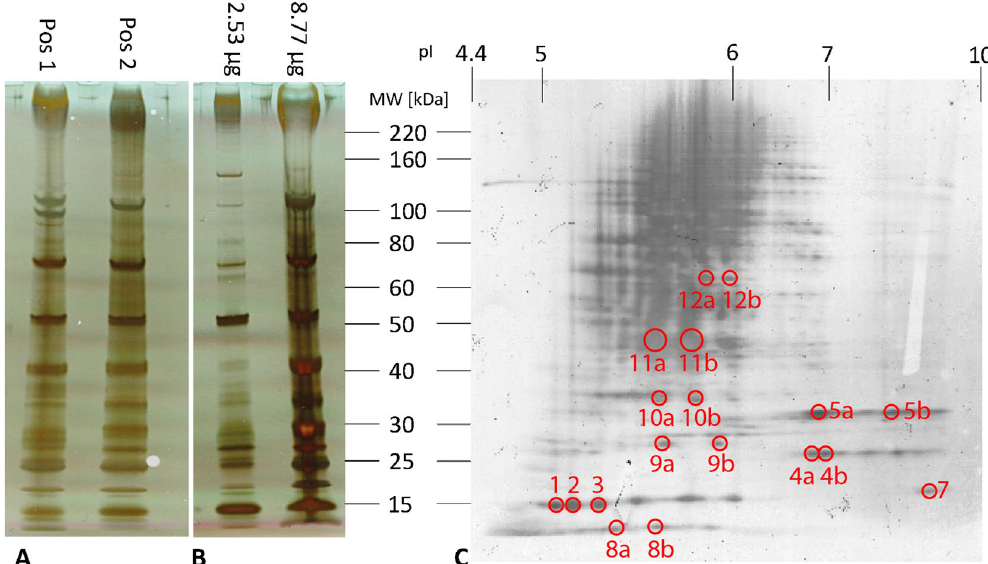
Figure 5. 1D- and 2D-PAGE. 1D-PAGE of the salamander secretion ( A ) extracted with LDS buffer from two different positions of an Aclar ® foil (approx. 0.75 cm 2 each) and ( B ) different concentrations of bioadhesive scratched from the Aclar ® foil over an area of 2 cm 2 solubilized in LDS buffer. ( C ) 2D-PAGE of 44 µ g protein extracted from a salamander